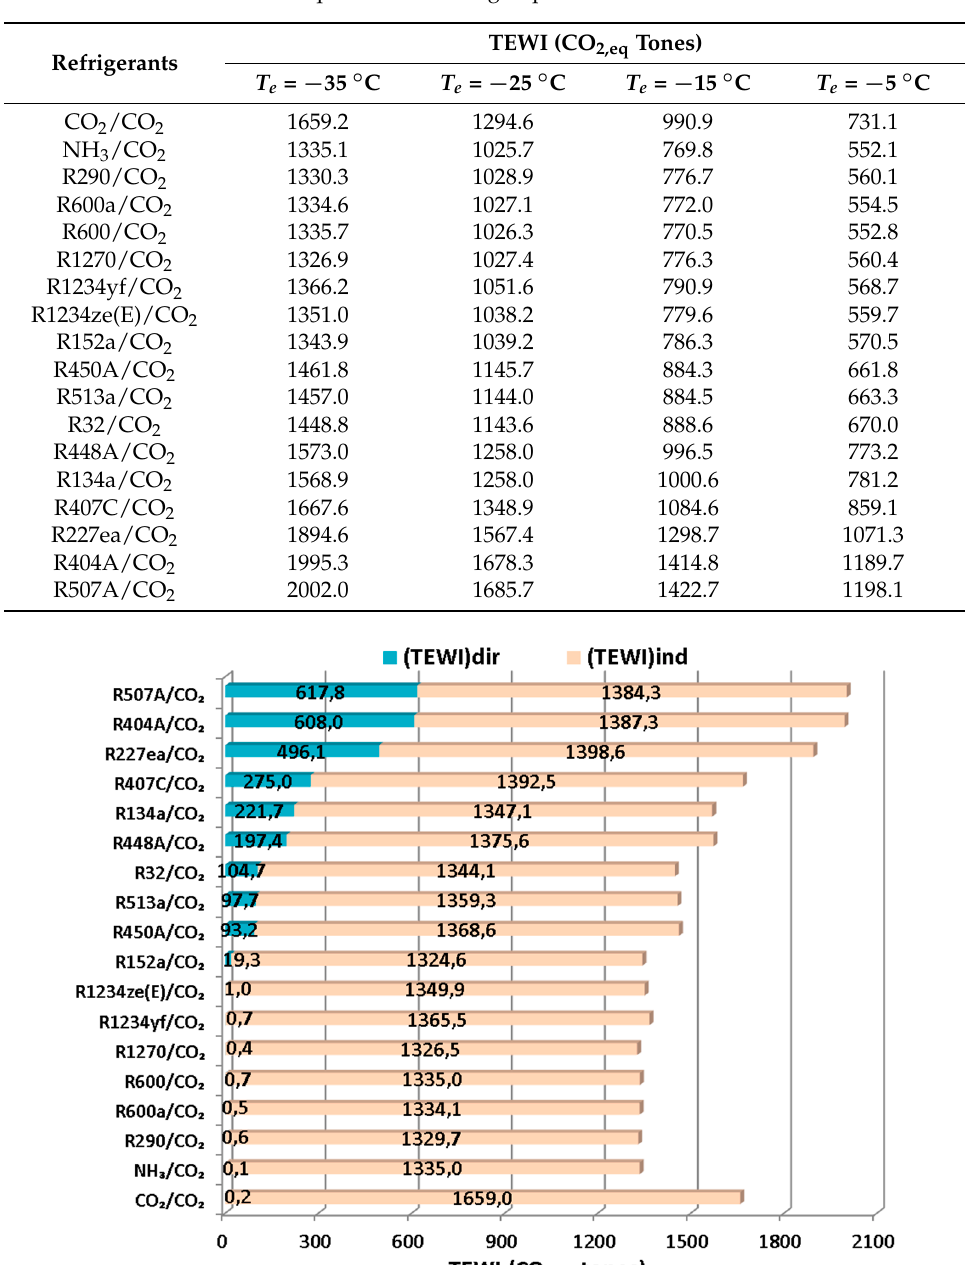
Table 4. Total equivalent warming impact for the examined cases.